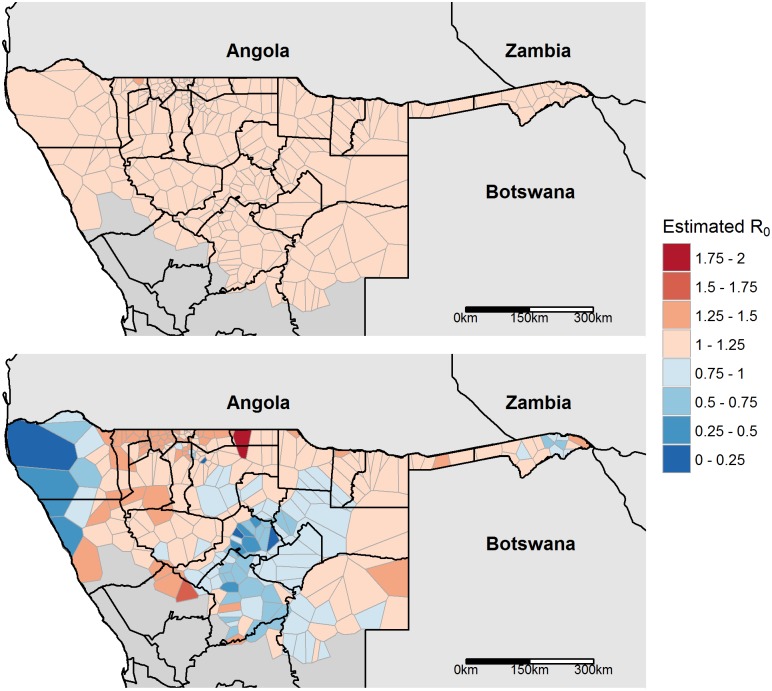
Predicted extent of transmission foci using pre-elimination parasite rate estimates.Top panel: Predictions from classical model analysed at steady state. Bottom panel: Predictions from multipatch model. Areas where R0 > 1 shown in shades of red while areas where R0 < 1 shown in shades of blue. Only areas with nonzero PR are shown; these areas were predicted to have R0 < 1 in both models. Patch outlines shown in grey, health district boundaries in black. In the steady state analysis of the classical model, all patches with PR > 0 are predicted to have 1.25 > R0 > 1 except one bordering Angola where R0 = 1.27 (darker red).